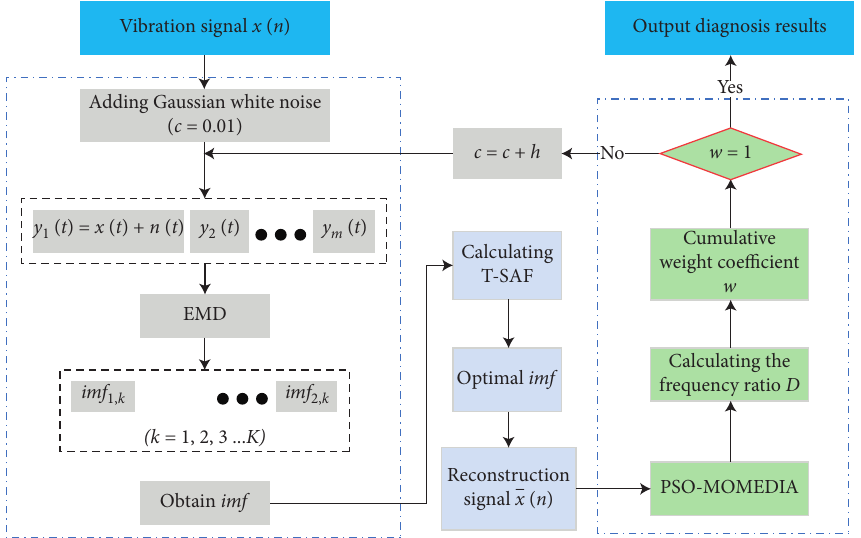
Figure 11: Steps of automatic diagnosis method for hoist bearing with unknown